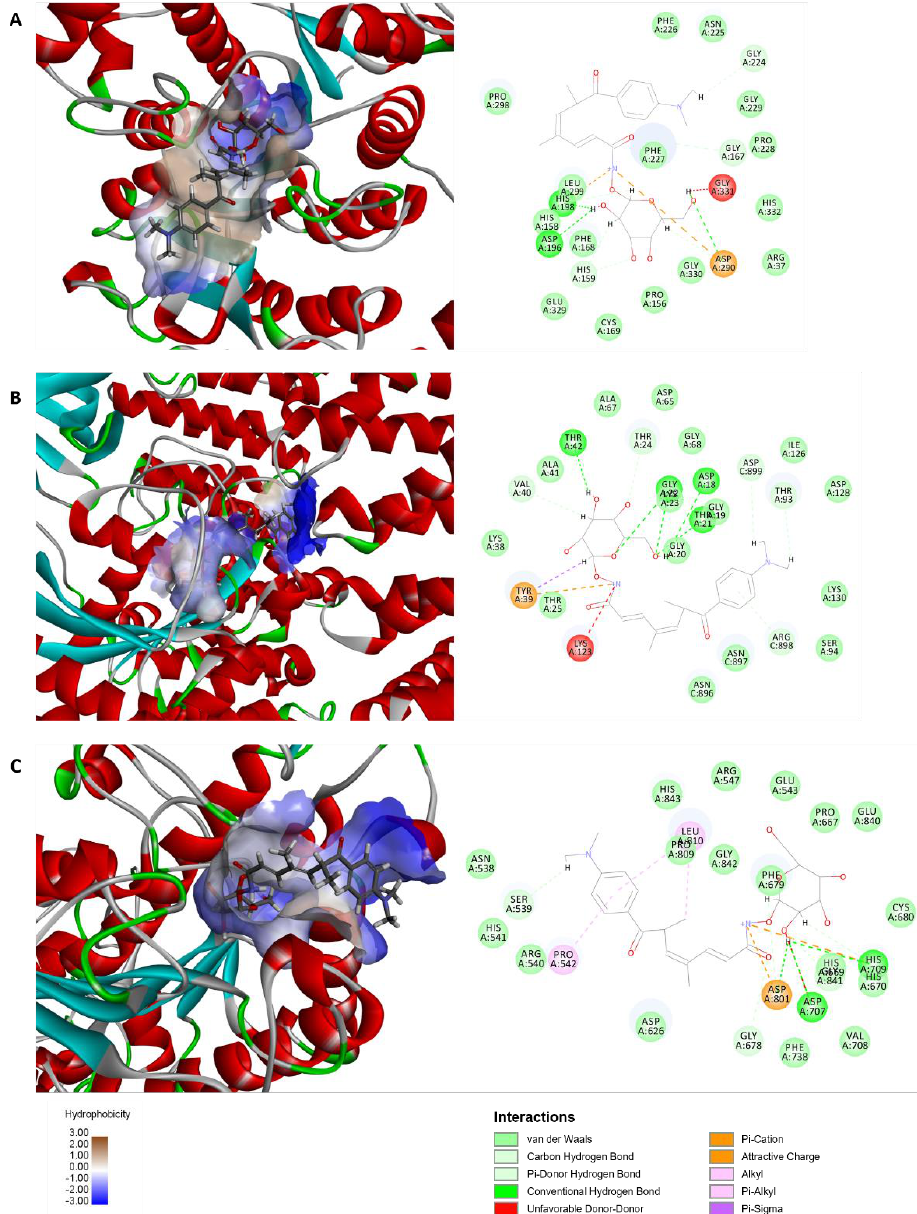
Figure 6. Molecular docking analysis between HDAC4, HDAC5, and HDAC7 proteins with TSD by Discovery Studio 4.5. 3D and 2D modes of the interaction pocket between ( A ) TSD with HDAC4, ( B ) TSD with HDAC5, and ( C ) TSD with HDAC7.